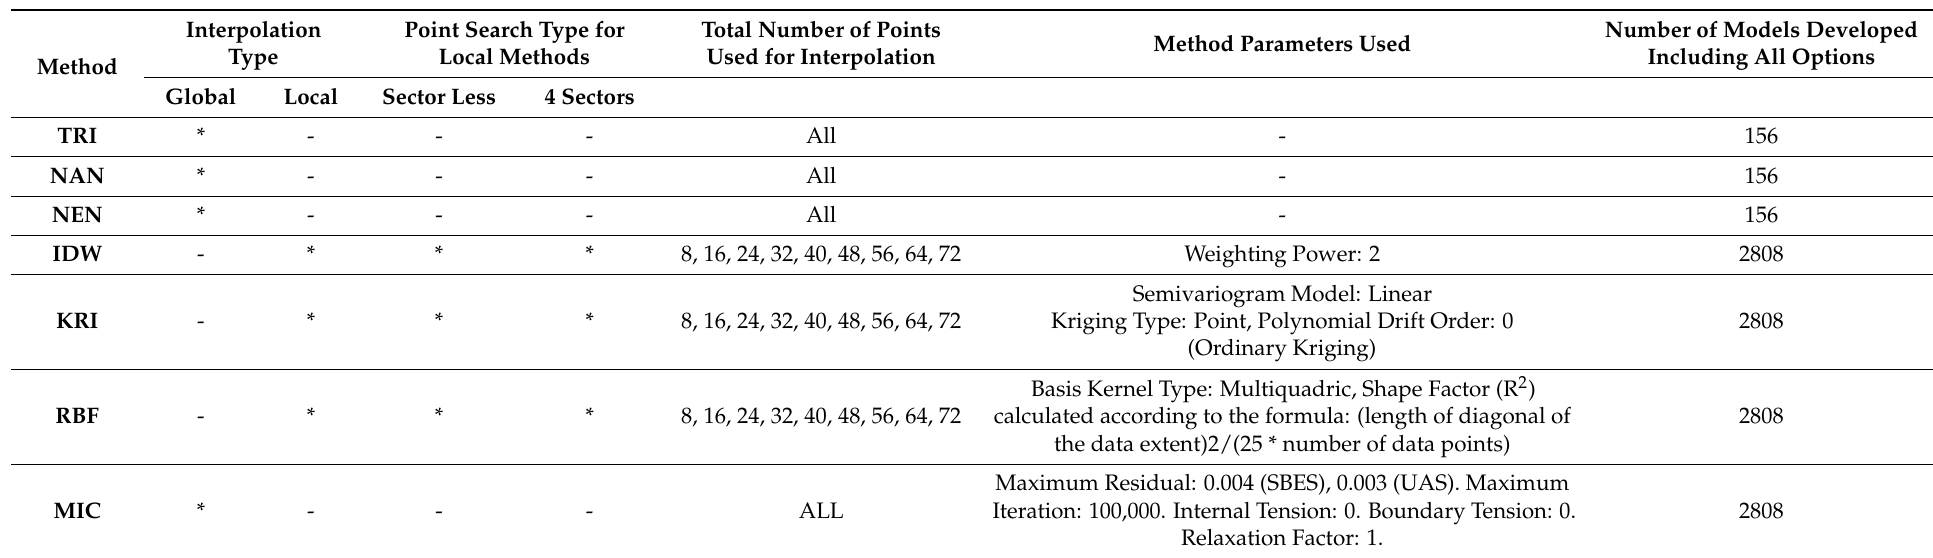
Table 5. Interpolation methods used in the